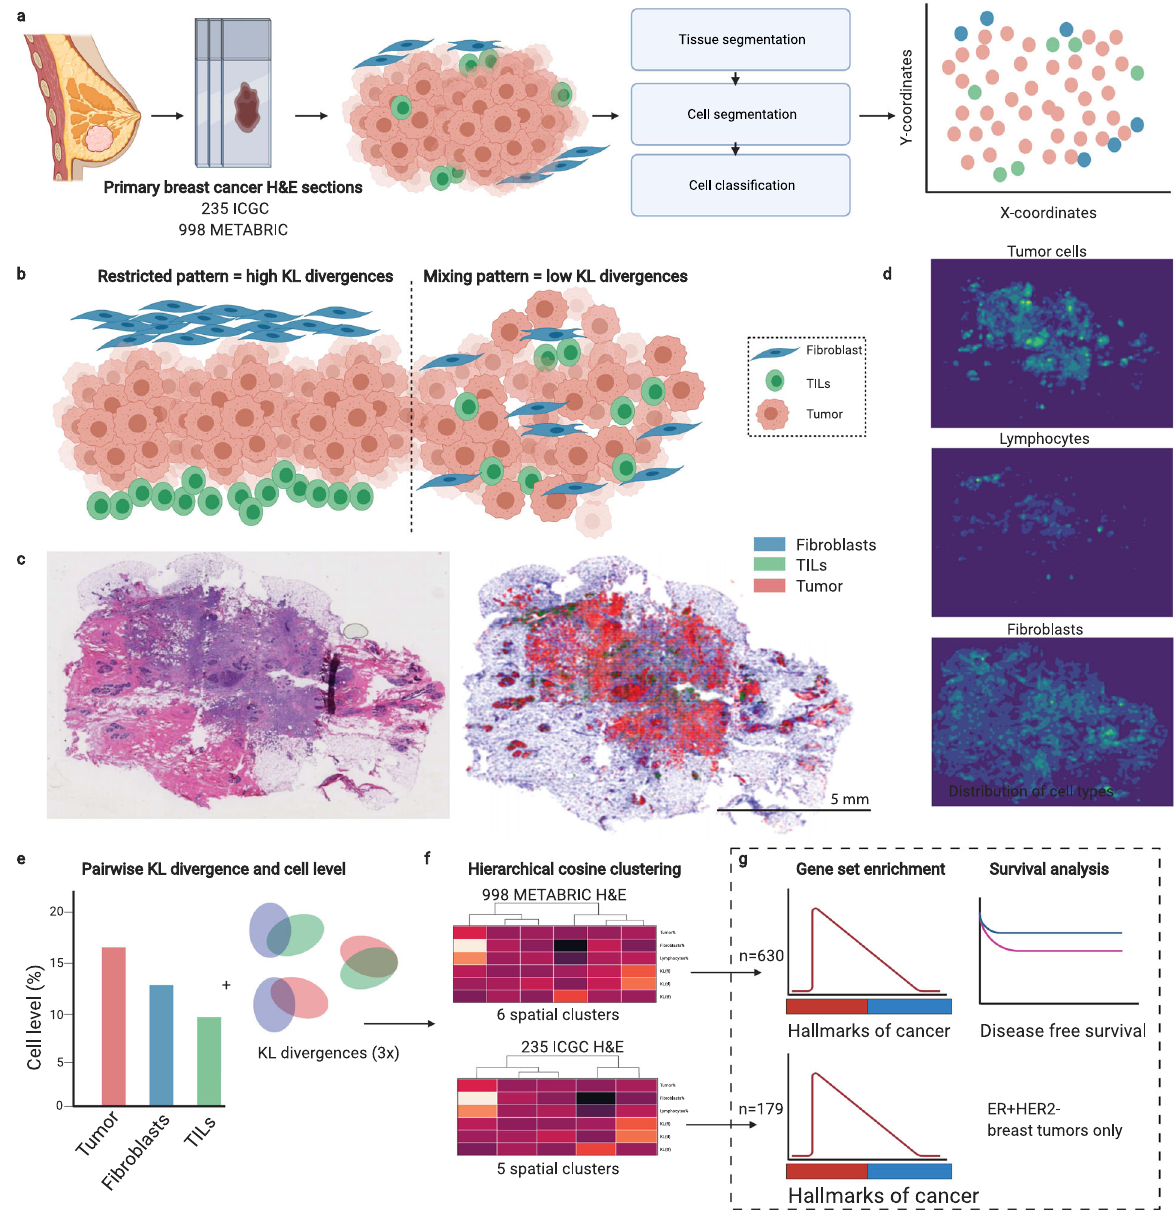
Fig. 1 The analysis pipeline for automated image analysis and subsequent clustering of H&E slides. a Overview of the cohorts used and schematic illustration of the deep neural network-based pipeline for the processing of FFPE H&E slides. b Schematic examples of tumors with high KL-divergences (restricted patterns) and low KL-divergences (mixed patterns). c Example of FFPE H&E image and output of cell detection and classi fi cation. Scalebar indicates 5 mm. d Cell density distribution plots of H&E image under c . e Explanatory illustration of the three fractional levels of cell types, namely the cell type percentage of TILs, fi broblasts and tumor cells, and three measures to describe the mixing or restriction of the three different cell type distributions. The resulting six variables were used to cluster patients based on their H&E slides. f Hierarchical clustering of the patients in the ICGC cohort and METABRIC cohort separately. g Downstream analyses of molecular characteristics and survival of ER + HER2 − patients only. estimation on the ICGC cohort 24 (Fig. S1a, c), the deep-learning and 4133 other cells. The model reached an accuracy on average of 91.9% for the classi fi cation of cells (accuracy per cell type; Table S1). model detected signi fi cantly lower TIL-AI levels in ER + tumors Cells detected with the deep neural network are hereafter referred versus ER - tumors (10.5% vs. 17.9% resp., P = 0.019, Fig. S1b) and an to as TILs-AI , tumor-AI , and fi bro-AI . As expected, in tumors with high overall higher fi bro-AI levels in ER + tumors compared to ER − stromal TILs or high intratumoral TILs percentages as assessed by tumors (28.4% vs. 22.4% resp., P = 0.016 by Wilcoxon-rank test, Fig. pathologists, a higher TILs-AI level was detected (Fig. 2c, ICGC S1b). As expected, tumor-AI levels were equal between ER + and cohort, Fig. S1d R-sq = 0.176). In line with various immune cell ER − tumors (58.3% vs. 60.0%, P = 0.99 by Wilcoxon-rank test, Fig. estimates (TIL, cytotoxic T cells, B cells, regulatory T cells, fi broblasts; S1b). The occurrence of a fi brotic scar on the H&E slides did not Fig. S1a, c) identi fi ed by standard pathology IHC 23 and a RNA-based interfere with the overall % of TILs-AI or Fibro-AI (Fig. S1d, e). npj Breast Cancer (2022)